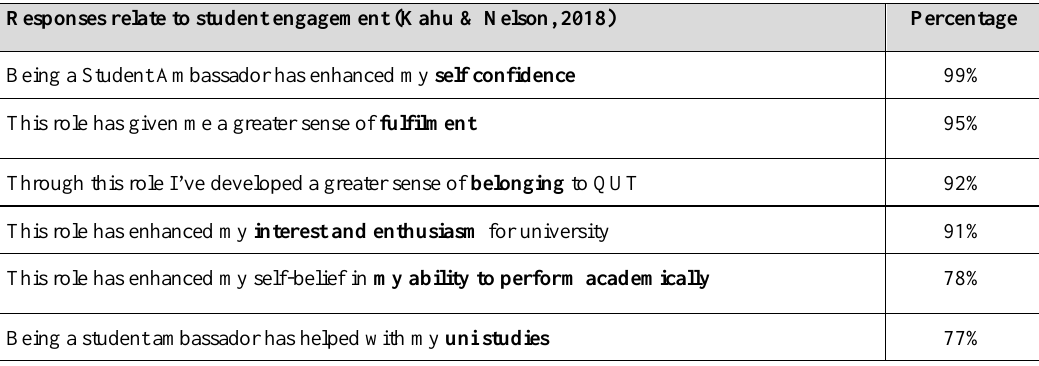
Influence of the student ambassador role on the ambassadors (expressed as a percentage of strongly agree/agree